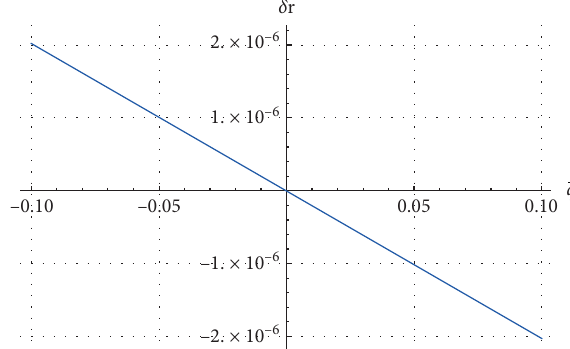
Figure 4: The variation of L against the specific charge.